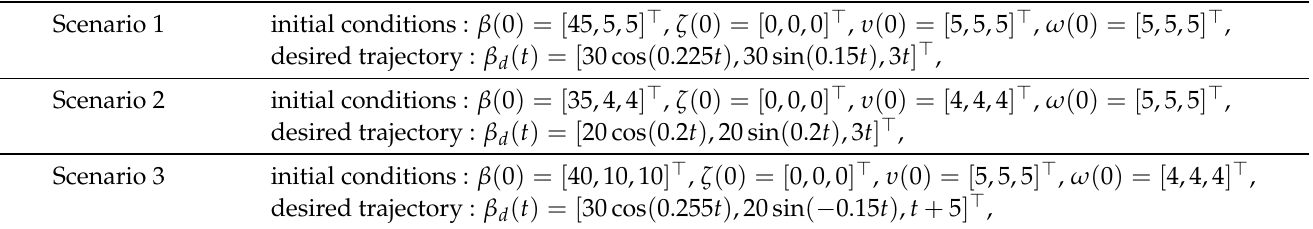
Table 1. Conditions of desired trajectory, initial positions and velocities of the UUVs.